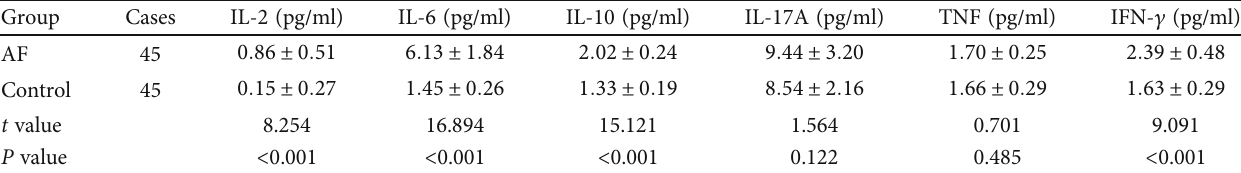
Table 5: Comparison of the expression of in fl ammatory factors in external blood between the two groups ð x ± s Þ . Group Cases